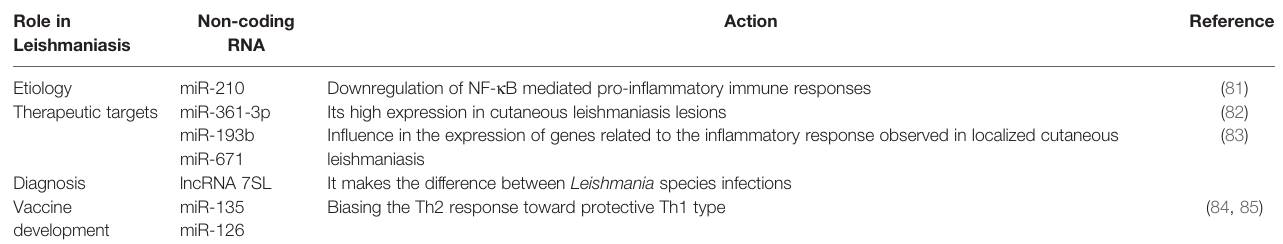
TABLE 3 | Non-coding RNAs in the etiology and control of